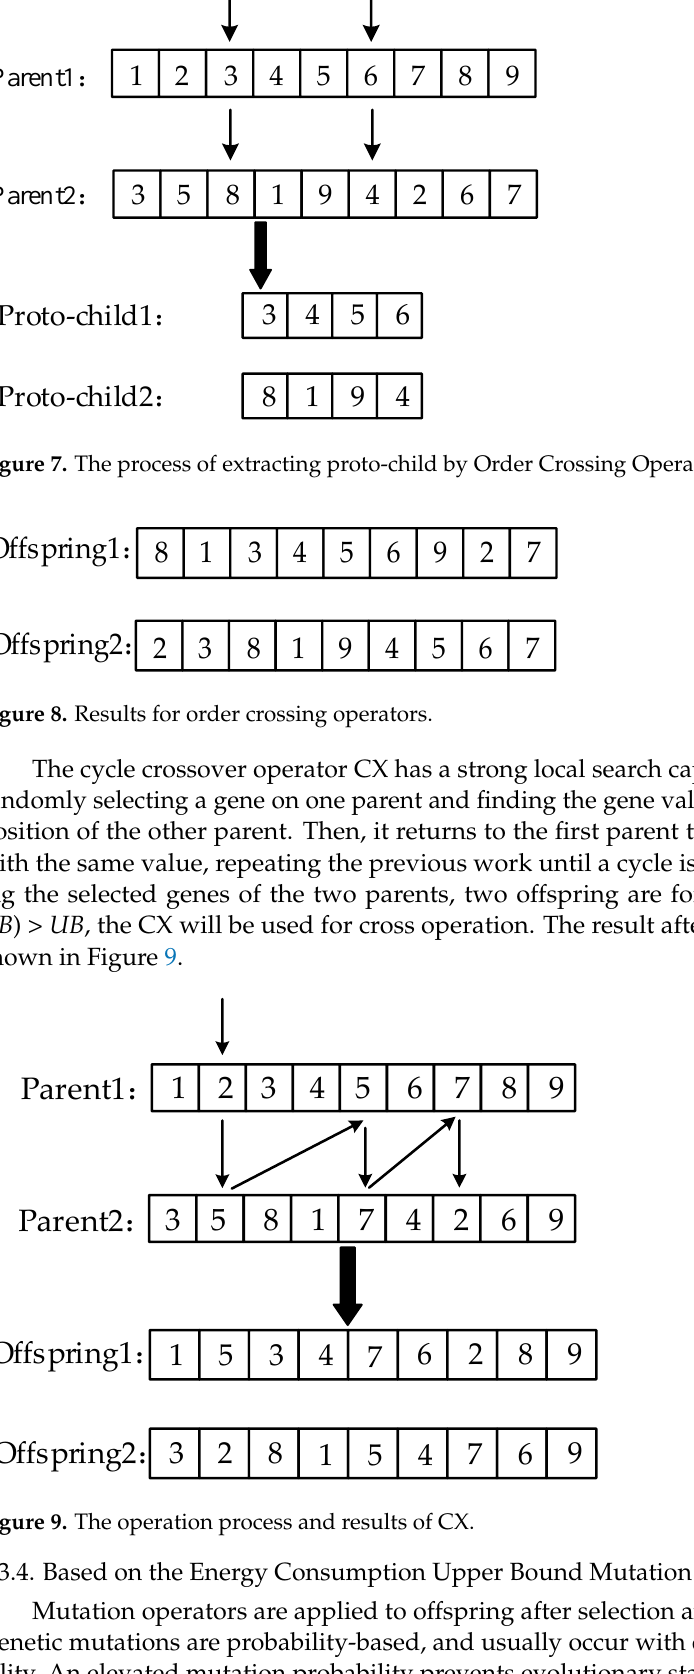
6489 Figure 10. The operation procedure and results of mutation operator. 2.3.5. Flow of the Large Scale Feeding Point Path Planning Approach The steps of the double-crossover operator genetic algorithm based on an upper bound on energy consumption are as follows and its simulation process is given in Figure 11. Step 1: Obtain feed weight information and coordinate information of the feed bucket, which are transmitted to the feeding robot through the infinite communication module of the feed bucket. Step 2: Randomly generate the initial population and determine various parameters related to it, such as the number of selected individuals N = 10 and the upper bound value of energy consumption. The crossover probability is P c = 0.8, the mutation probabilities is P 1 and P 2 and the maximum number of iterations is T max = 1,000, with a population size S = 500.